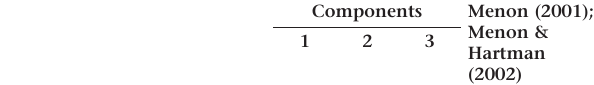
The above table indicates that the factor structure for the Asian and Coloured group does not reflect the same structure as that found in international research.